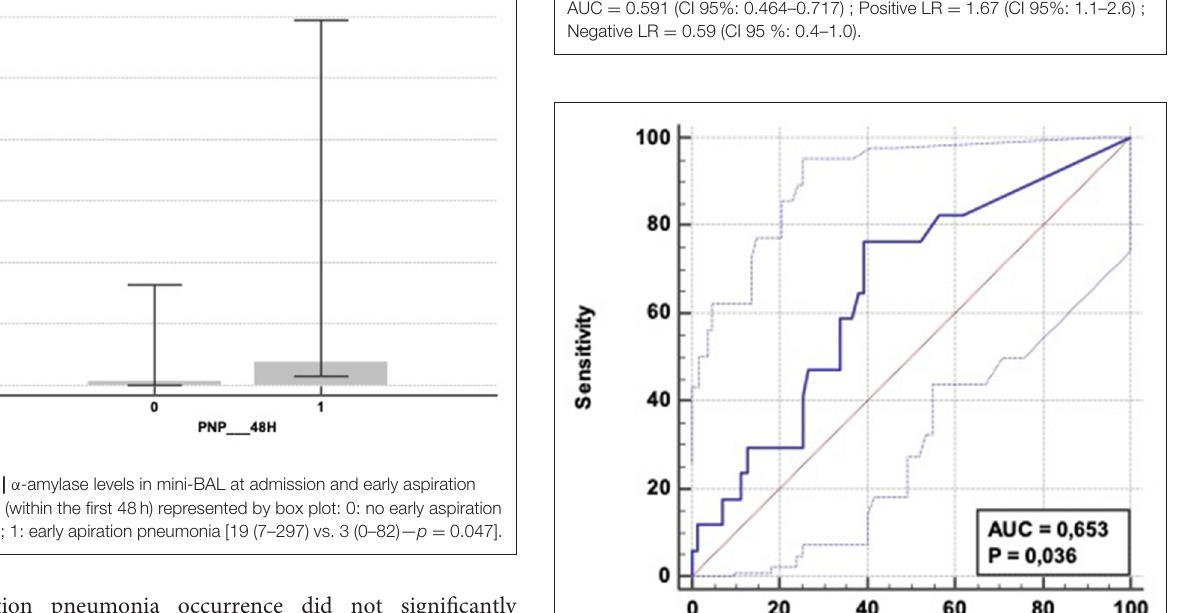
FIGURE 3 | ROC curve: Diagnostic ability of α -amylase level to predict aspiration pneumonia occurrence within 5 days following OHCA admission.